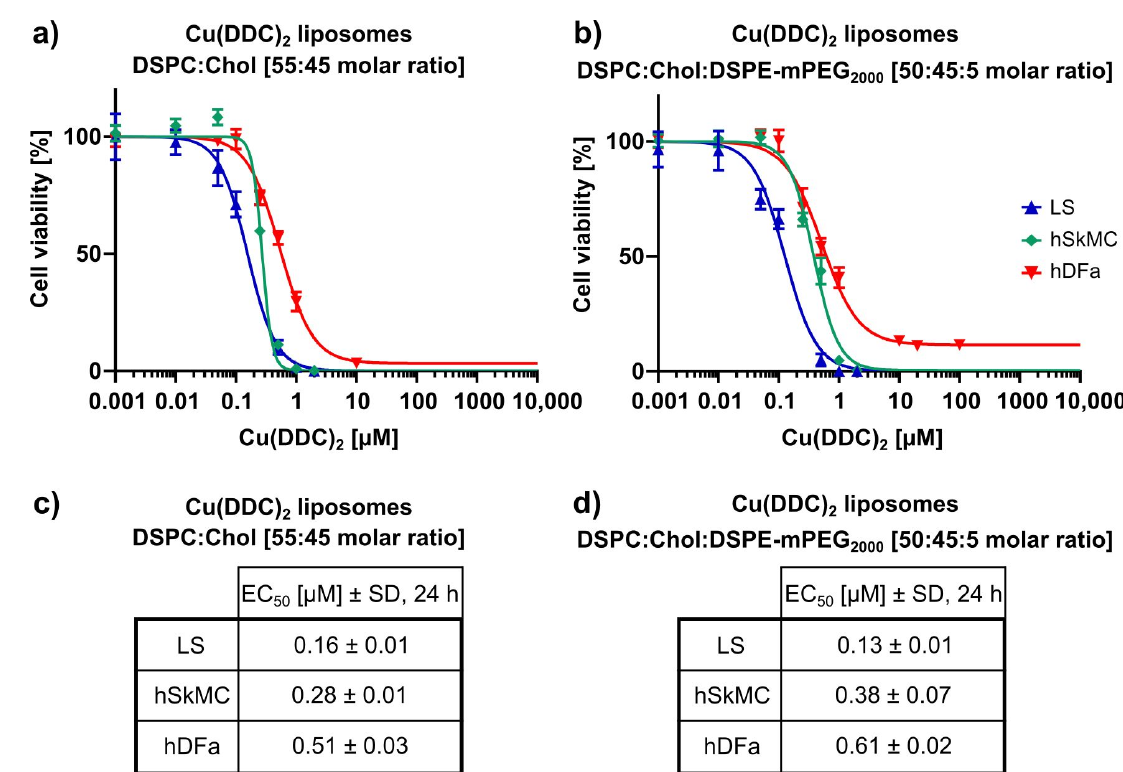
Figure 10. In vitro cytotoxicity of Cu(DDC) 2 liposomes on 2D hSkMC and 2D hDFa monoculture cell models. ( a , b ) 2D monolayers of LS, hSkMC, and hDFa cells were incubated with non-PEGylated ( a ) and PEGylated ( b ) Cu(DDC) 2 liposomes for 24 h. Cell viability was analyzed using the 2D CellTiter-Glo ® assay after indicated treatment duration. ( c , d ) EC 50 values after 24 h of treatment with non-PEGylated ( c ) and PEGylated ( d ) Cu(DDC) 2 liposomes. Data are expressed as the mean ± SD ( n = 3).